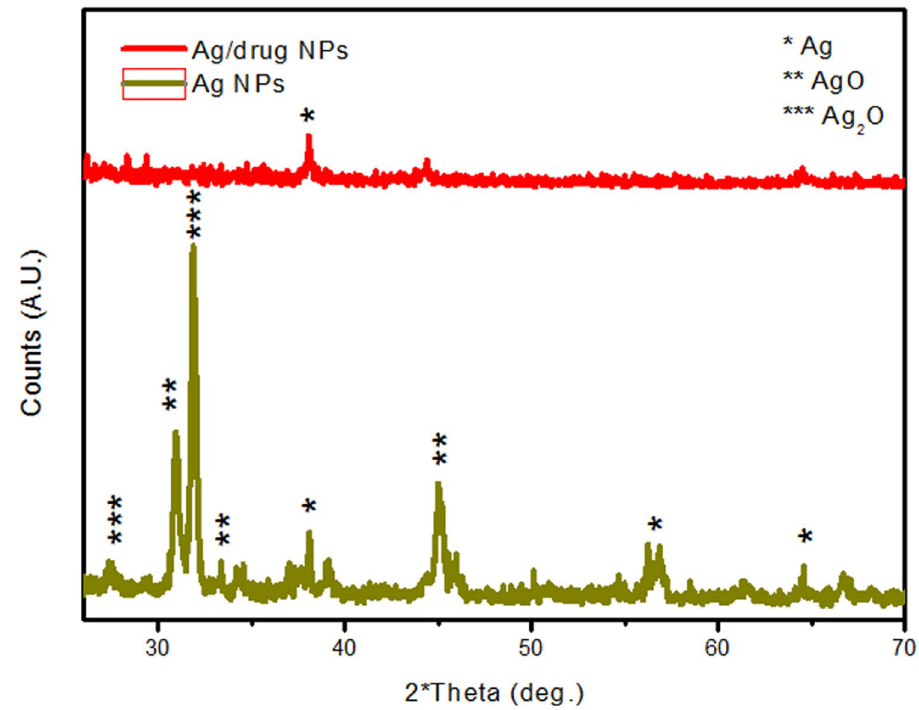
Figure 2. X-ray Diffraction (XRD) of silver nanoparticles before and after Virokill loading, showing characteristic peaks for silver and its oxides AgO and Ag 2 O, indicating successfully incorporated of Virokill disinfectant within the silver nanoparticles.